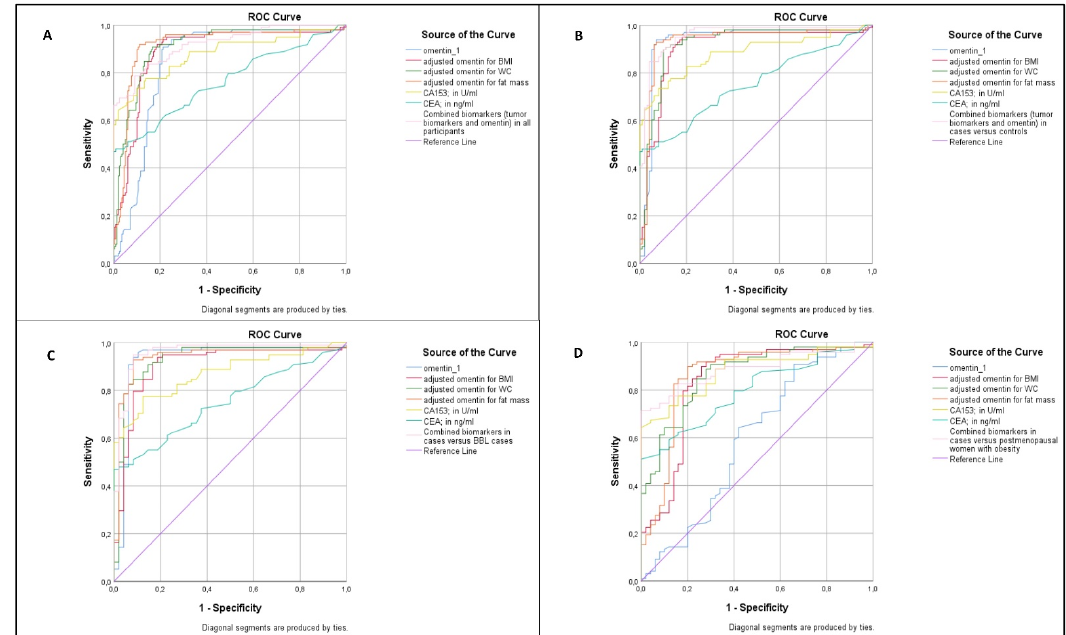
Figure 3. ( A ) Receiver operating characteristic (ROC) analysis of serum omentin-1 (cases with PBC versus controls, patients with BBL, and postmenopausal women with obesity): omentin-1 (AUC (area under the curve) 0.84, 95% CI 0.79–0.89);